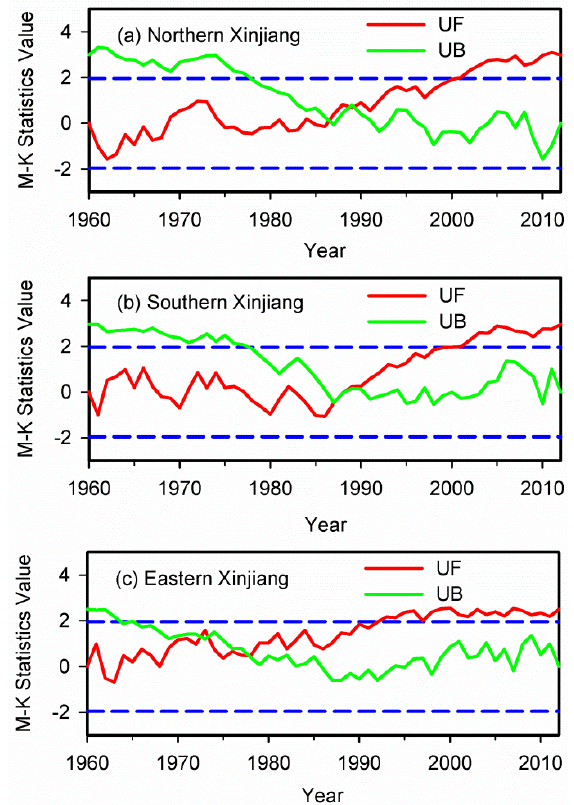
Figure 12. The M-K analysis results of average annual precipitation at 95% confidence level (the blue dash dotted lines) in ( a ) northern; ( b ) southern and ( c ) eastern Xinjiang during 1960–2012.